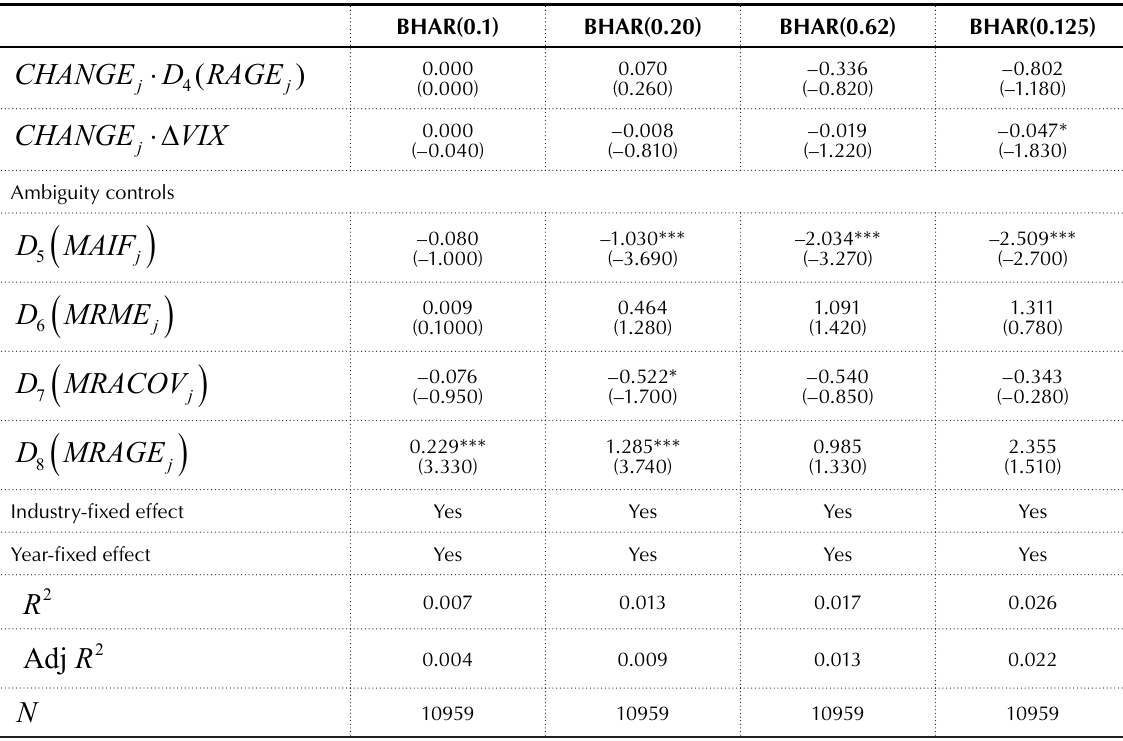
Table 4 (cont). Ambiguity and BHARs: controlling for